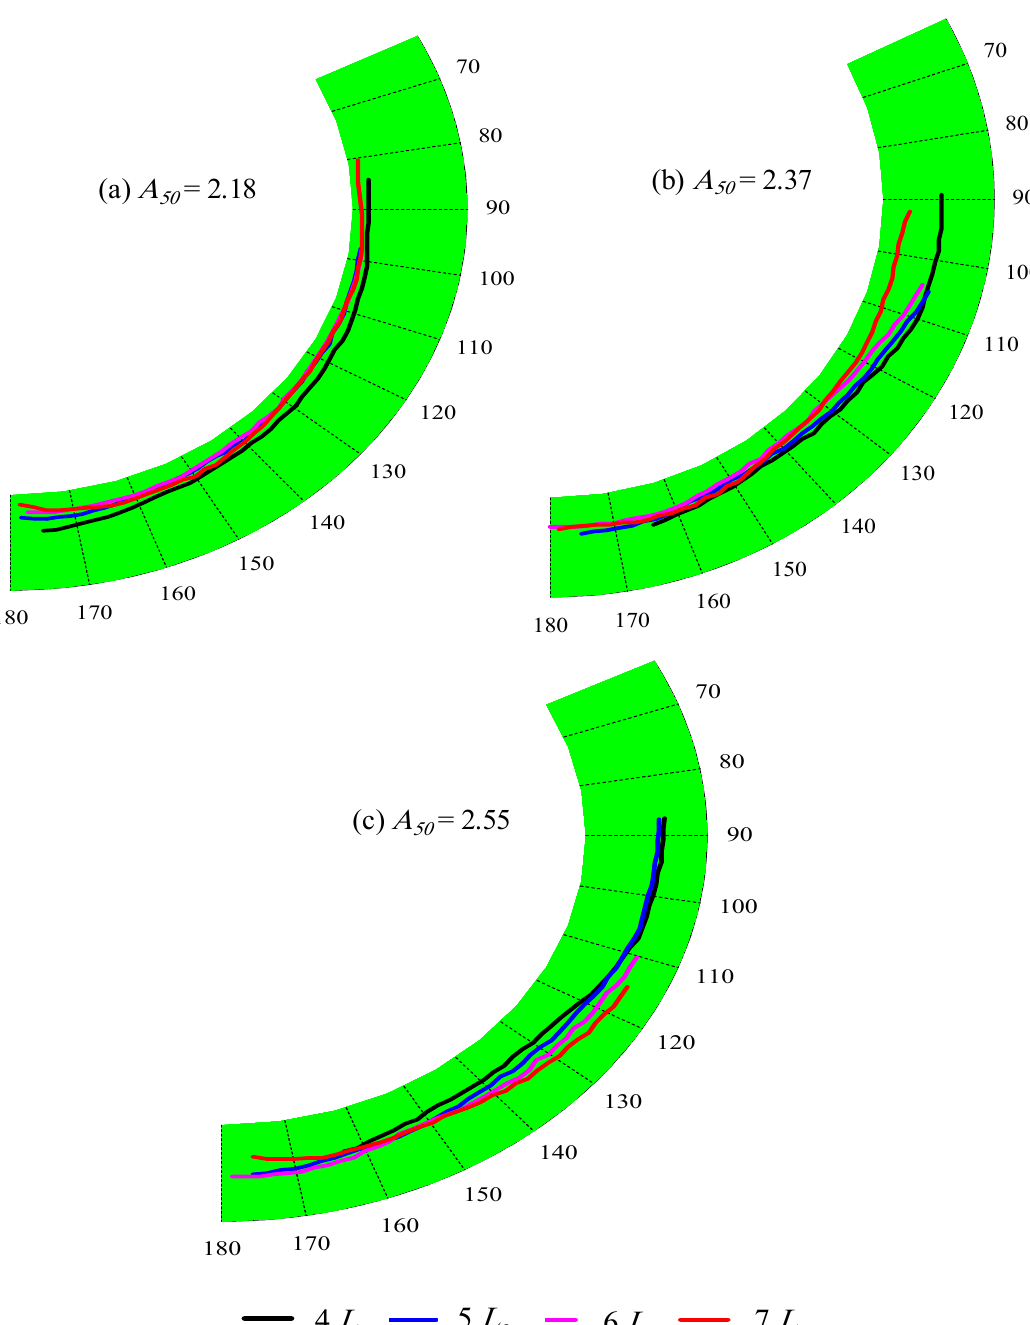
Figure 17. Variation of thalweg location at different spaces and hydraulic conditions. ( a ) A 50 = 2.18, ( b ) A 50 = 2.37, and ( c ) A 50 = 2.55.